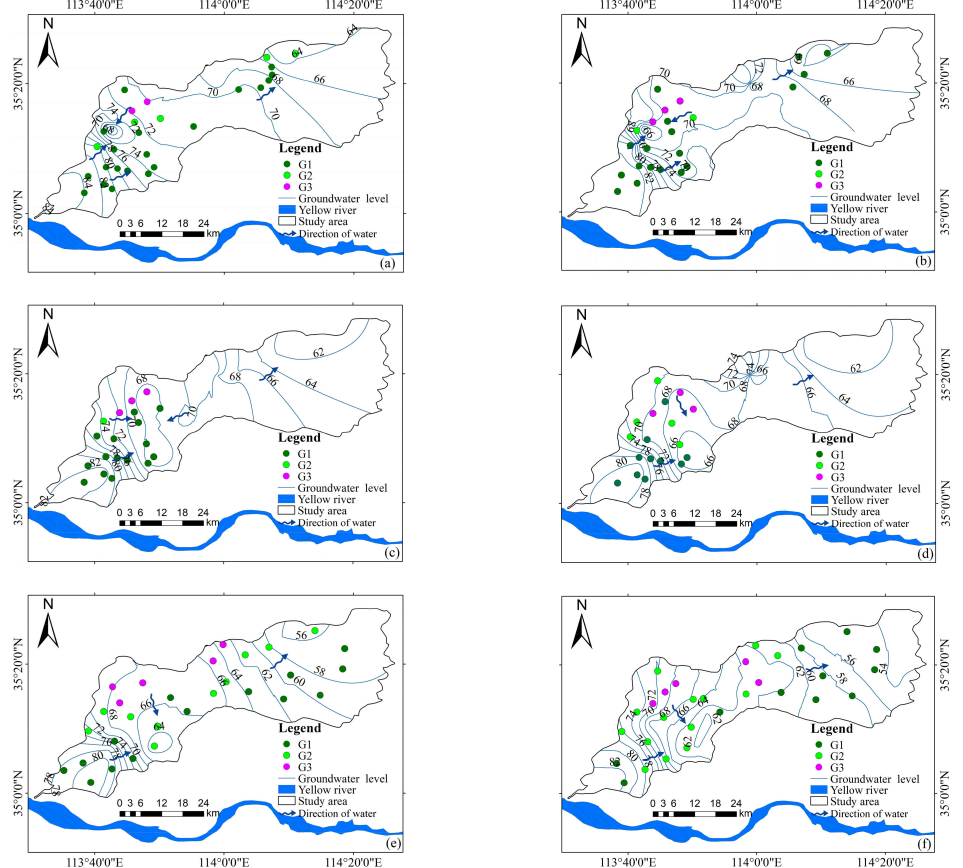
Figure 6. Spatial distribution of clusters representing years (( a – f ) are 1996, 2001, 2003, 2013, 2016, and 2022,